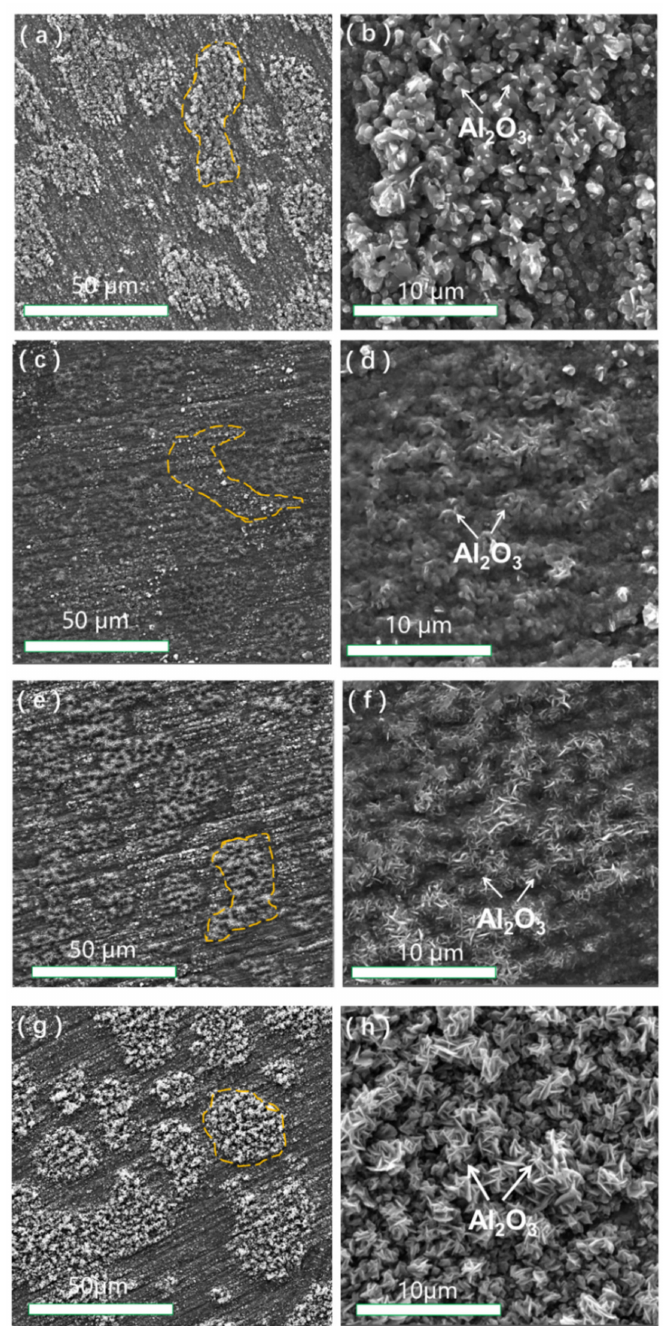
Figure 2. The surface morphologies of the oxide scale formed on the NiCrAlHf bond coat alloy after 24 h of oxidation at 1100 ◦ C: ( a ) in air and stepped heating conditions; ( b ) the high magnification area of ( a ); ( c ) in air and constant heating conditions; ( d ) the high magnification area of ( c ); ( e ) in water vapor and stepped heating conditions; ( f ) the high magnification area of ( e ); ( g ) in water vapor and constant heating conditions; ( h ) the high magnification area of ( g